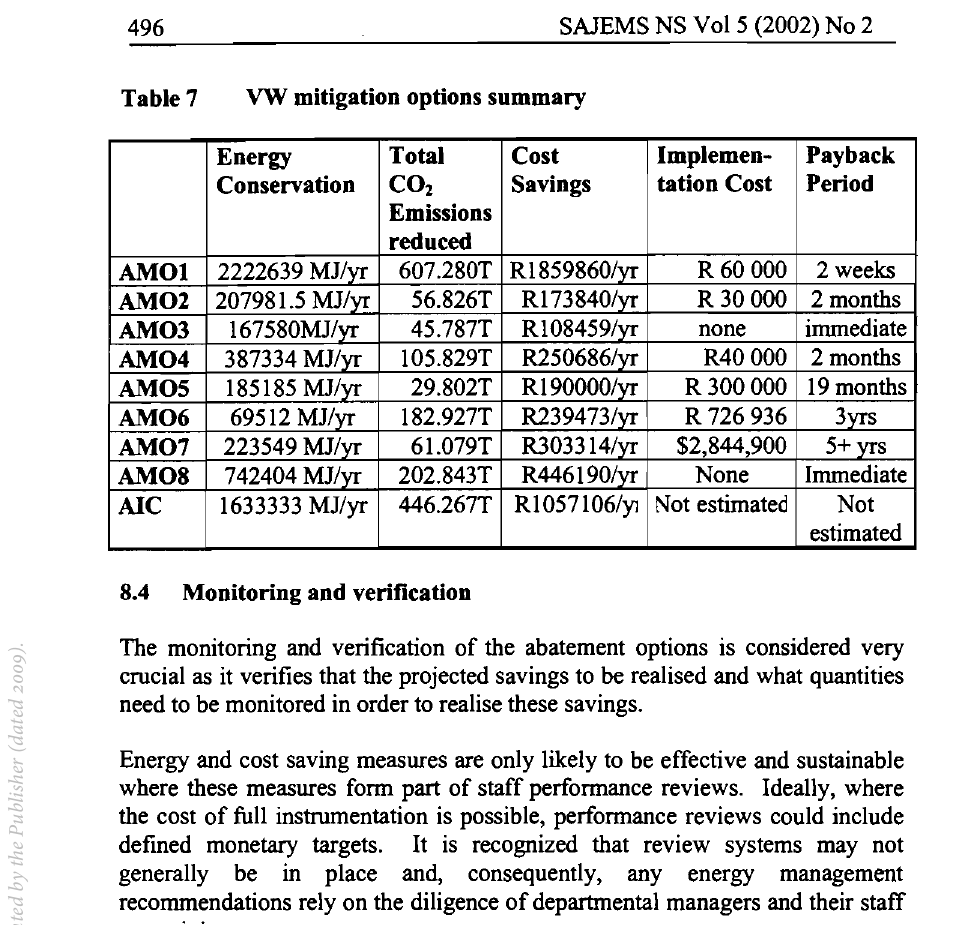
VW mitigation options